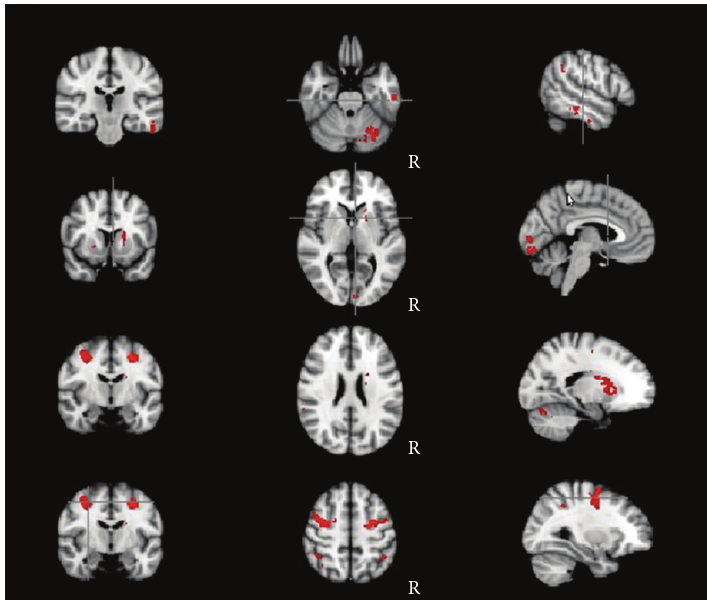
Figure 2: Conjunction of young and old adult activation: regions activated by both groups are highlighted in red. They comprise the right cerebellum, the right inferior temporal gyrus, the right striatum, the right occipital cortex, bifrontal rolandic cortex (hand area), and bilateral prefrontal cortex. Neurological convention—right of the subject on the axial image on the right of the figure.